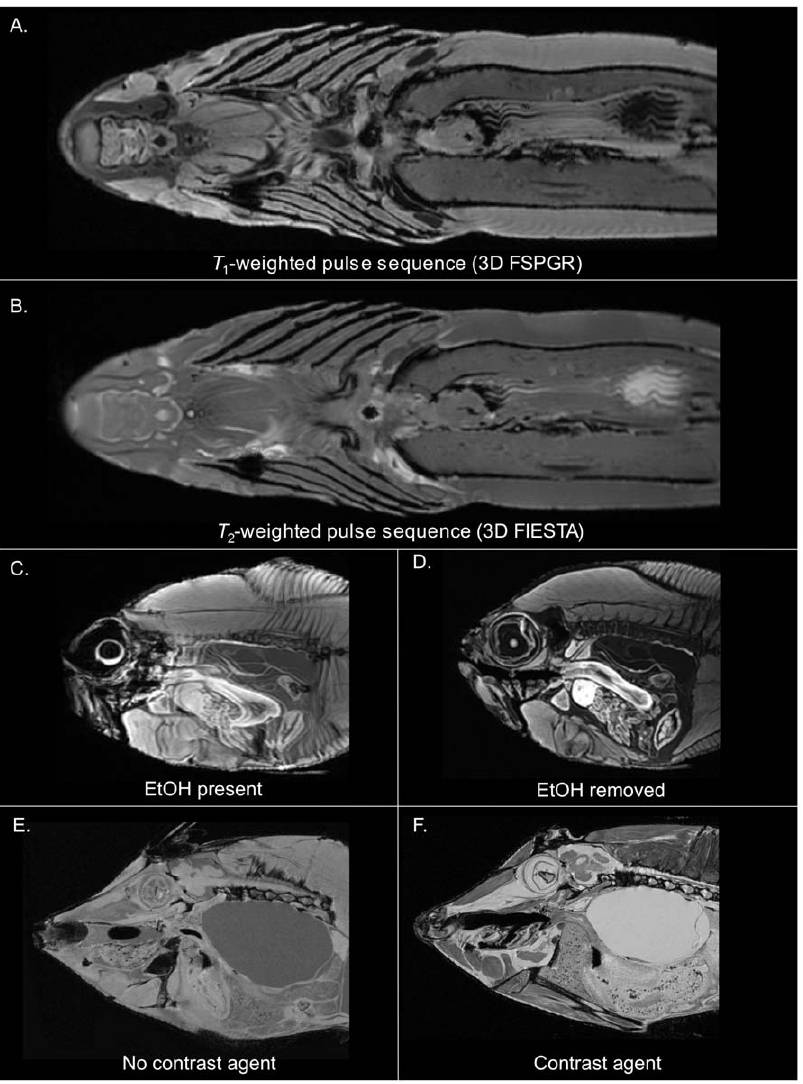
Figure 2. Optimizing preparation and scanning of museum specimens. (A) Comparison of T1-weighted 3D FSPGR (fast-spoiled gradient- recalled echo) and (B) T2-weighted 3D FIESTA MRI pulse sequences acquired on the 3 T scanner (slice matrix=512 6 512 6 236, slice thickness=900 m m, resolution=683 m m 3 , averages=2) in the smooth hammerhead, Sphyrna lewini (SIO 64-528, SL 104 cm). Additional parameters for the T1-weighted 3D Fast-Spoiled Gradient Echo (FSPGR) pulse sequence include, FA=35 u , TR=9.86 ms, TE=4.112 ms, and for the T2-weighted 3D FIESTA pulse sequence, FA=40 u , TR=4.456 ms, TE=2.1 ms. (C) The red bream, Beryx decadactylus (SIO 85-77; SL 289 mm), was initially imaged with a T1-weighted FSPGR pulse sequence on the 3 T scanner prior to rehydration, and (D) re-imaged following rehydration resulting in an enhanced image quality. Scan parameters: FA=30 u , TR=11.904 ms, TE=3.932 ms, slice matrix=512 6 512 6 236, slice thickness=600 m m, resolution=527 m m 3 , averages=3. (E) The fantail filefish, Pervagor spilosoma (SIO 53-539; SL 74 mm) was initially imaged on the 7 T scanner using a T1-weighted FLASH pulse sequence without exposure to contrast agent, ProHance. (F) It was subsequently reimaged following exposure to 2.5 mM ProHance, resulting in a significantly brighter MR signal and enhanced visual contrast among tissues. Scan parameters: FA=15 u , TR=25.875 ms, TE=12.853 ms,